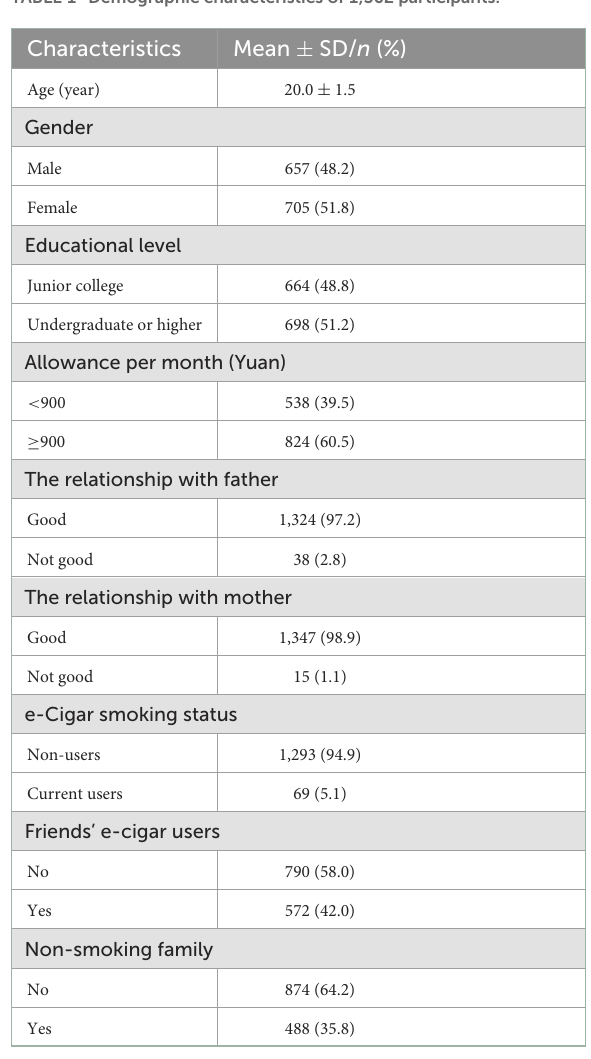
TABLE 1 Demographic characteristics of 1,362